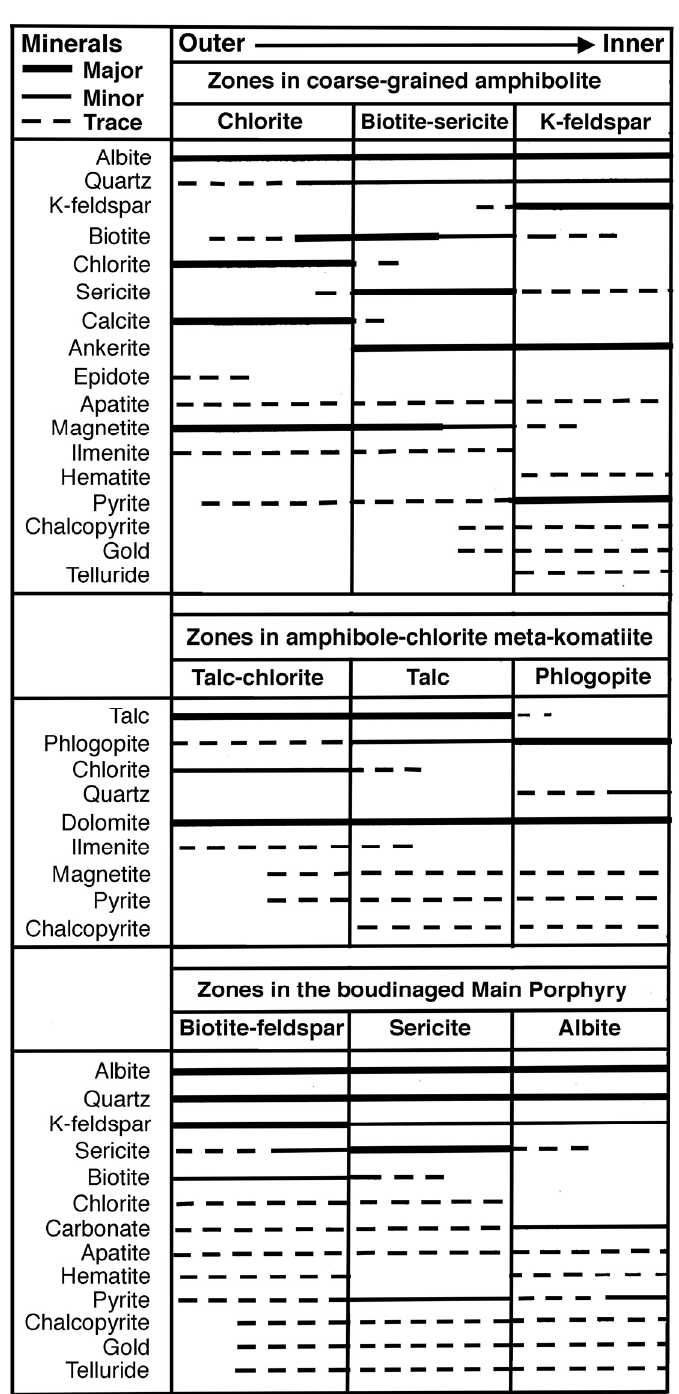
Figure 3. Paragenetic diagram of the main hydrothermal alteration zones in the three principal host rocks of the New Celebration gold deposit; compiled and modified according to own observations from data in [16,18,22].